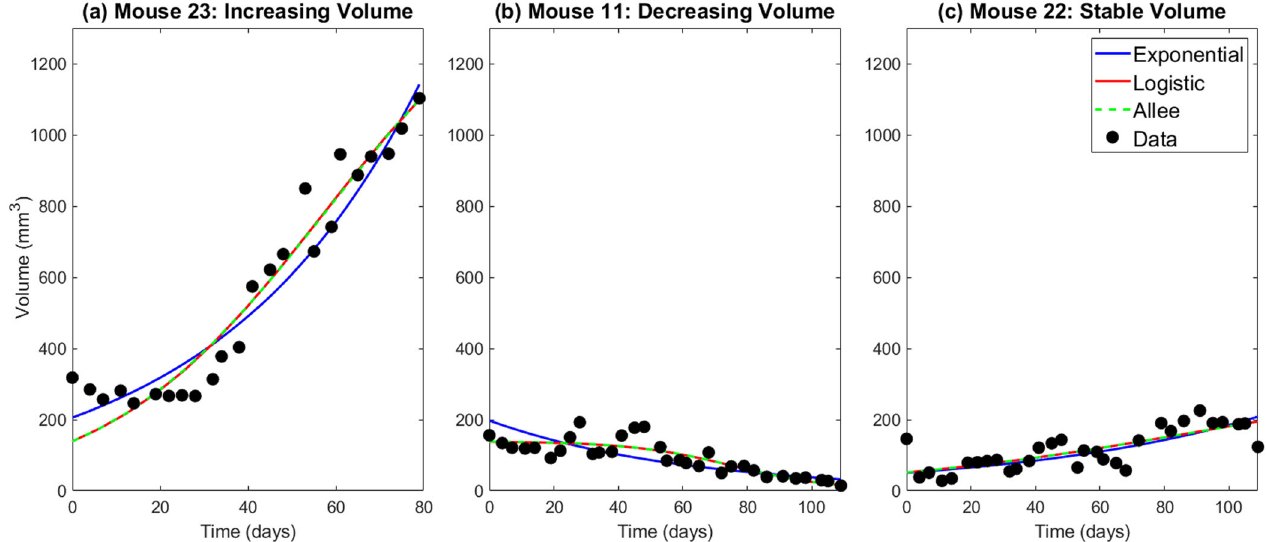
Fig. 2 Best fi t exponential, logistic, and Allee model for three representative mice. a Mouse 23 representing the case where the tumor volume increases. b Mouse 11 representing the case where the tumor volume decreases. c Mouse 22 representing the case where the tumor volume remains relatively